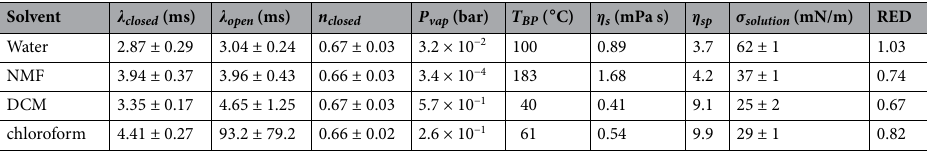
Table 1. Average (cid:31) E and n values for 3 mg/mL PEO solutions; ‘open’ indicates no environmental control whereas ‘closed’ occurs with the chamber sealed. Open and closed (cid:31) E values are statistically equal for water and NMF, whereas chloroform and DCM solutions exhibit longer (cid:31) E with the chamber open. Chloroform and DCM are more volatile (higher vapor pressures P vap and lower boiling points T BP ), less viscous ( η s ), and form lower surface tension ( σ solution ) solutions than water and NMF; specific viscosities, η sp , are also reported. All three organic solvents are predicted to be better solvents than water for PEO, given relative energy density (RED) values calculated from Hansen solubility parameters (SI.6) and shear rheology (SI.8).